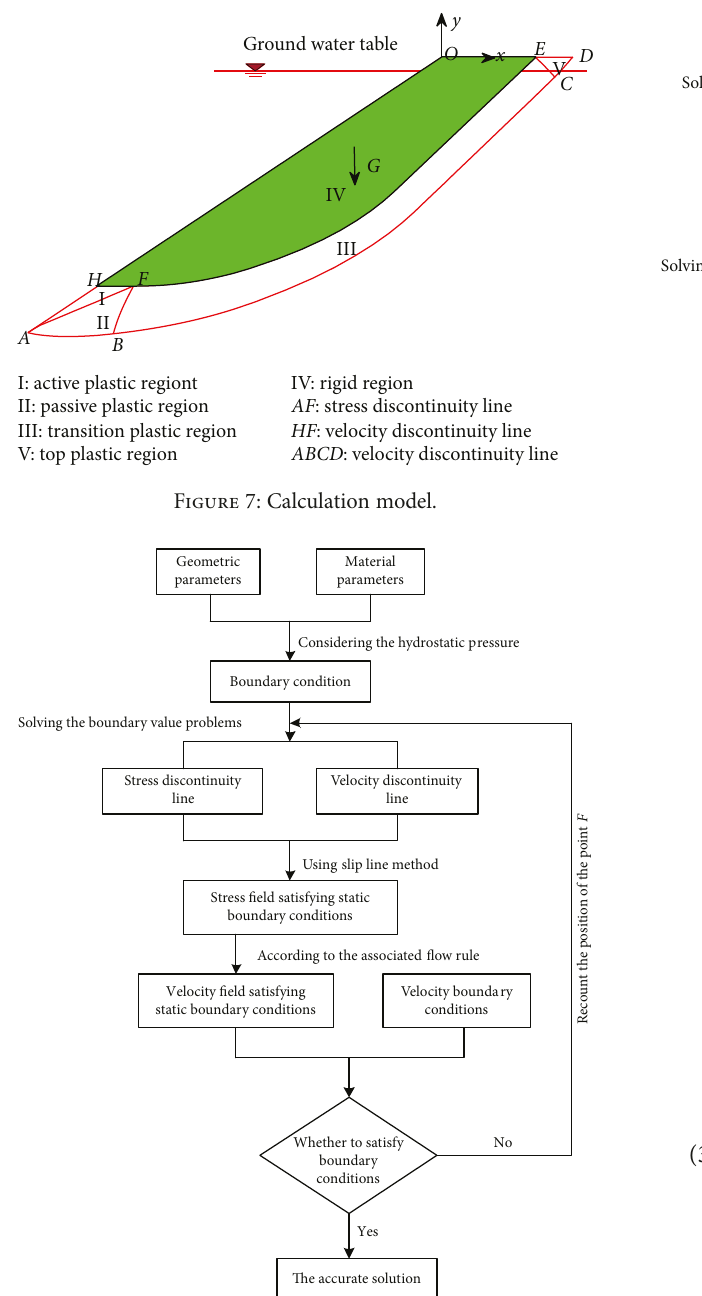
Figure 8: Flow chart of rigorous solution for slope stability.